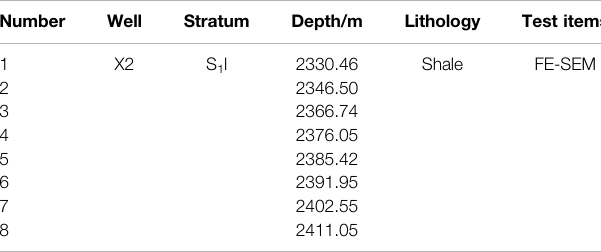
TABLE 1 | Information of shale samples in well